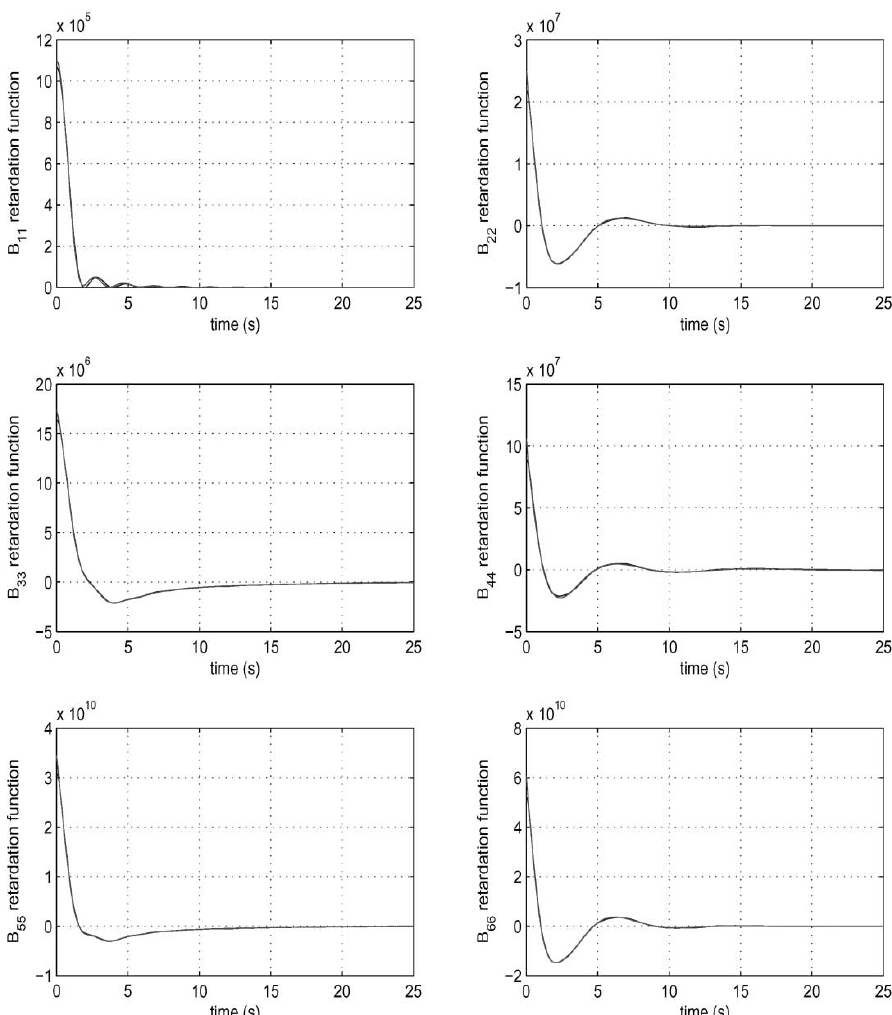
Figure 6. The retardation functions K are computed from equation (79) using trapezoidal ii integrations and plotted as a function of time t . The corresponding state-space models (5th- order) are plotted on top. This clearly shows that the state-space model accurately describe the retardation